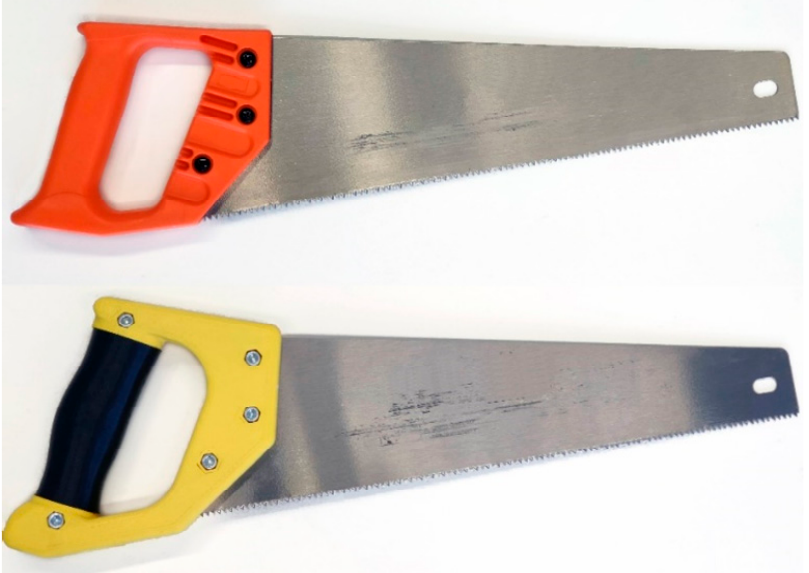
Figure 3. Original manufacturer’s saw ( top ) and the modified saw using deformable interface material ( bottom ).